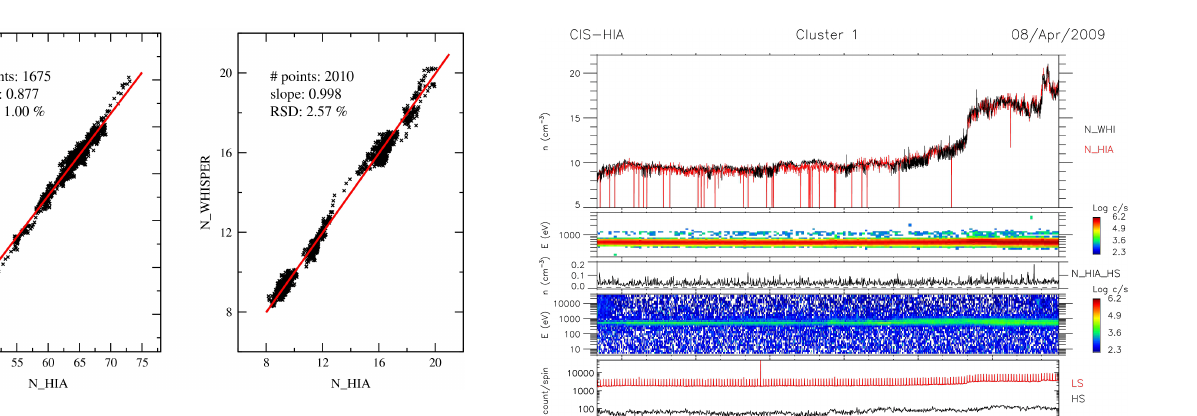
Fig. 4. HIA vs. WHISPER density comparison for the events pre- sented in Fig. 3 (left) and in Fig. 5 (right), employed to calibrate the HIA HS and LS sections, respectively. The slope of the regression line crossing the origin (in red) is used to estimate the calibration factor for the corresponding interval.